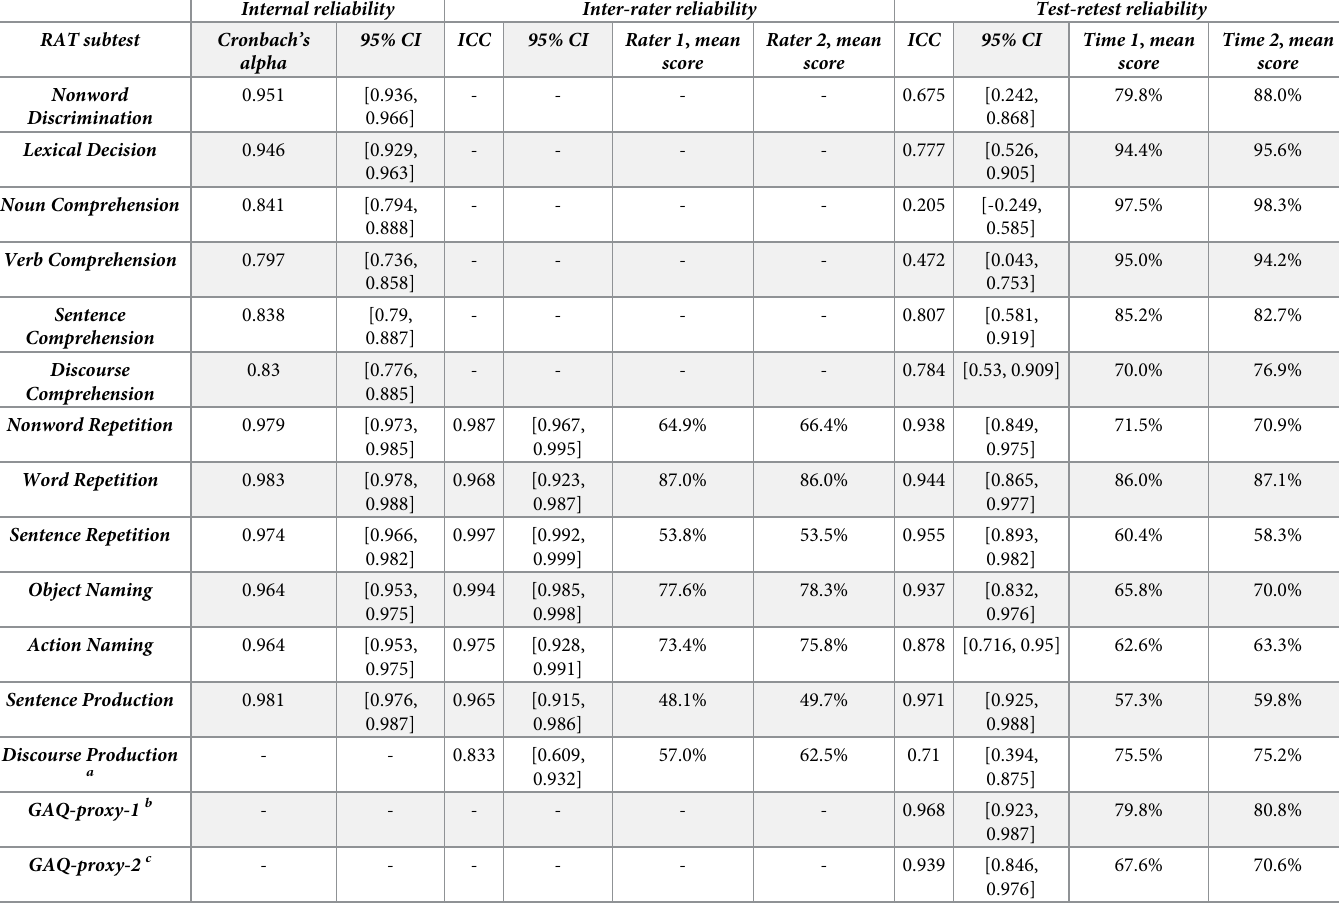
Table 4. Reliability estimates of the RAT subtests: internal reliability estimated with Cronbach’s alpha, inter-rater and test-retest reliability based on the intraclass correlation coefficients, absolute agreement (ICC, type